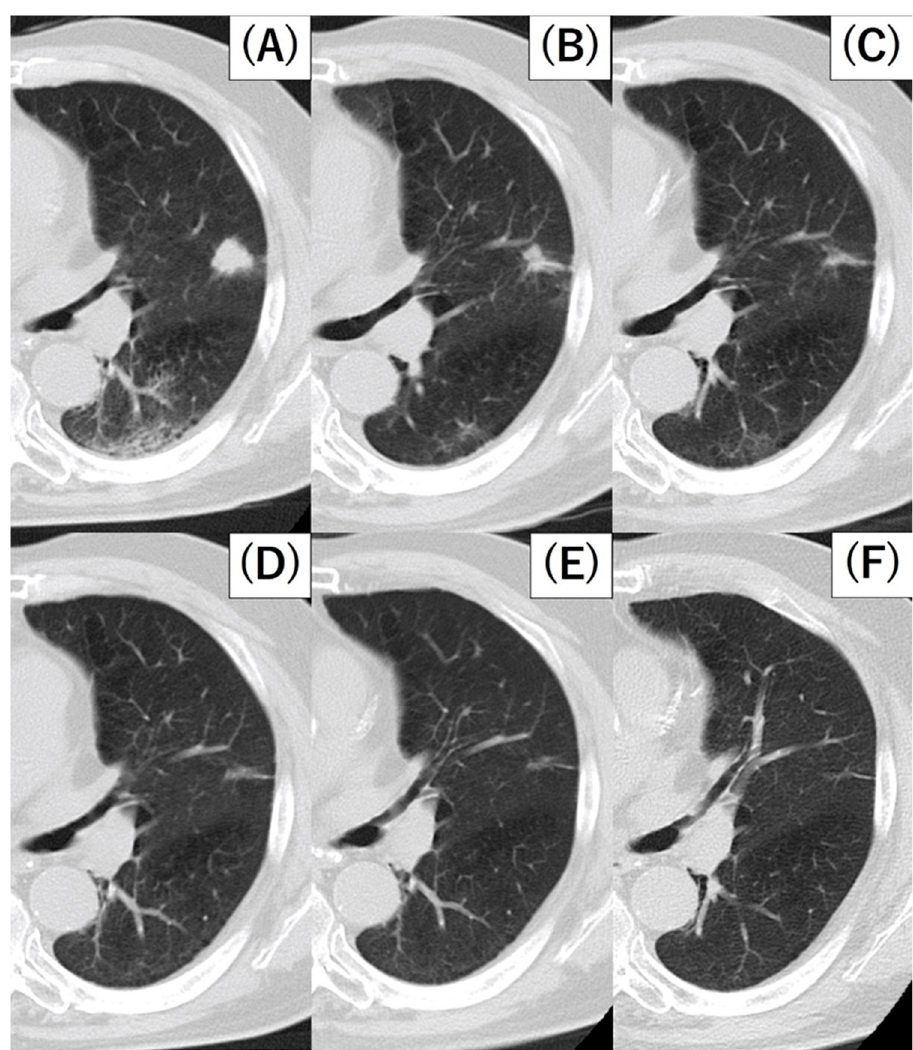
Figure 4. Chest CT images before biopsy ( A ), 35 days after biopsy ( B ), 67 days after biopsy ( C ), 118 days after biopsy ( D ), 12 months after biopsy ( E ), 20 months after biopsy ( F ). The S4 nodule in the left lung continued to shrink after biopsy without any anti-cancer therapy.